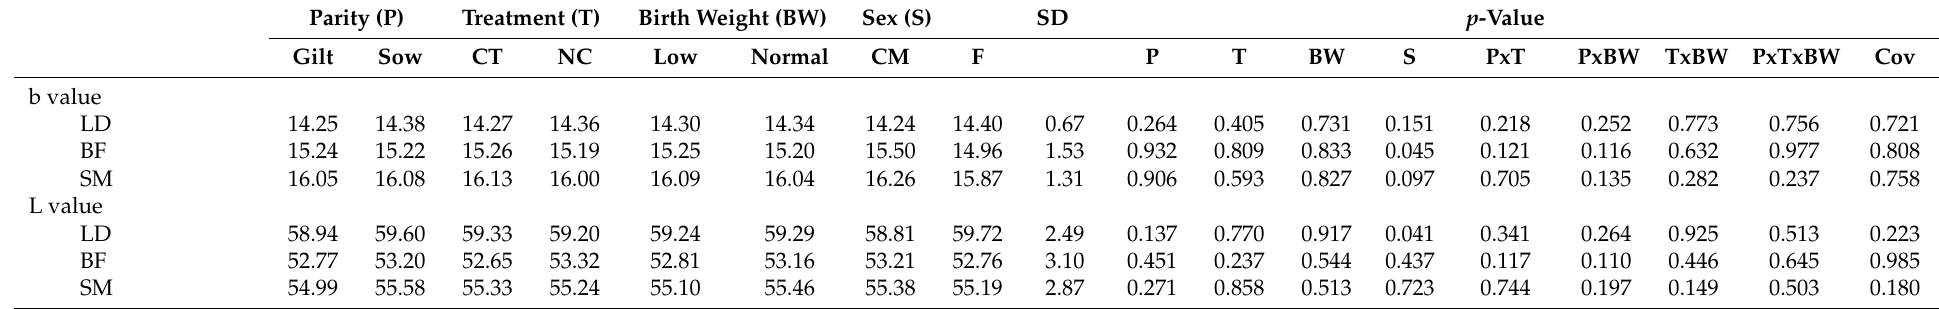
Table 5. Effect of parity (P), neonatal care treatment (T), birth weight (BW) and sex (S) on fatty acid composition of intramuscular lipids (covariable carcass